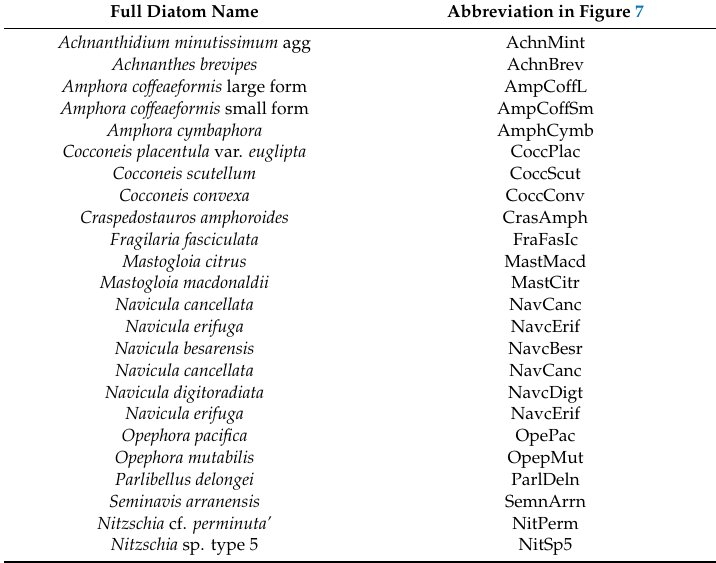
Table A1. Full diatom names and abbreviations used in Figure